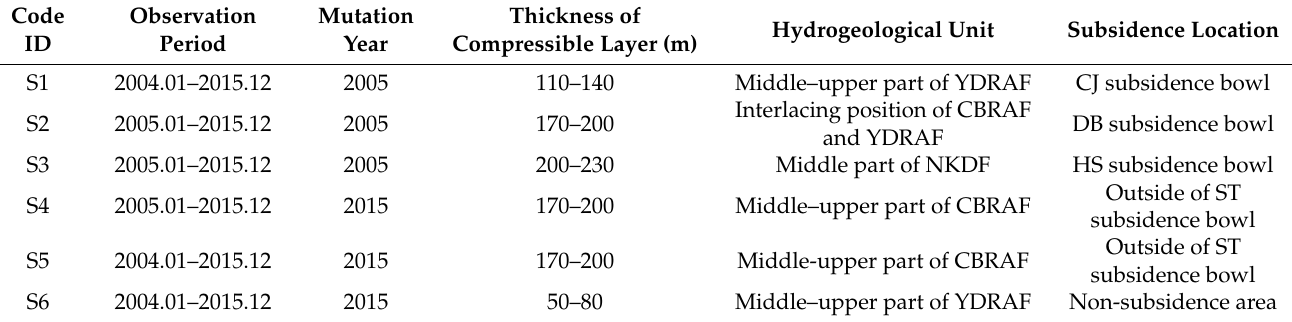
Table 4. Confined water observation well